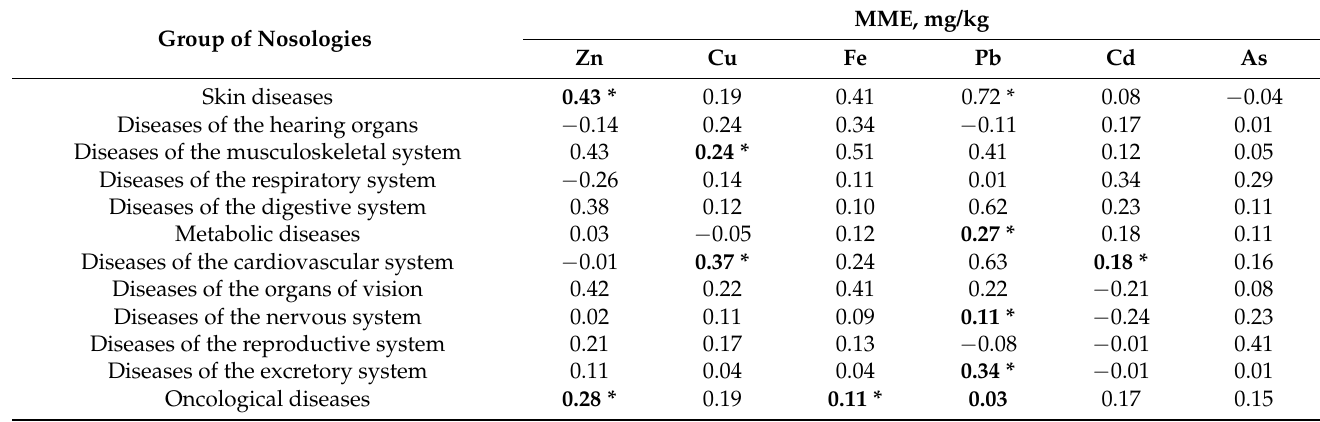
Table 1. Correlation between the MME content (mg/kg) in samples of derived integument with general morbidity of certain classes of diseases (with a proven role of environmental factors).